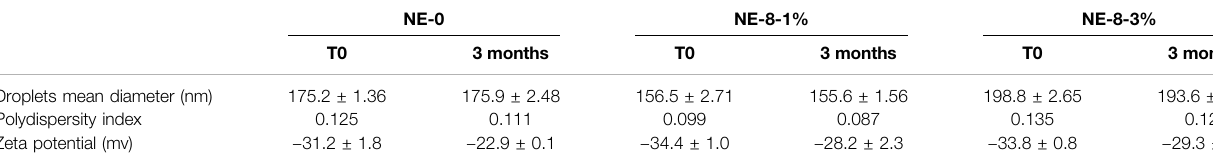
Droplets mean diameter (nm)